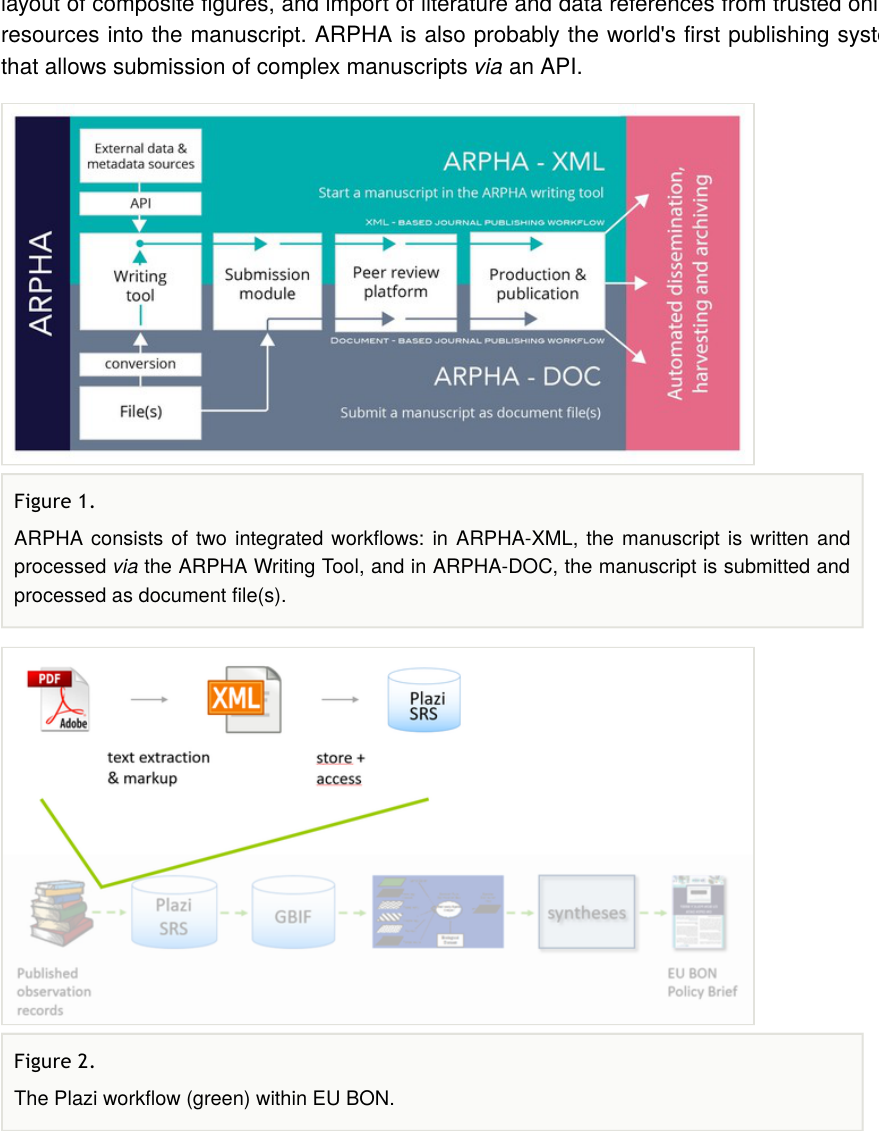
The Plazi work fl ow (green) within EU